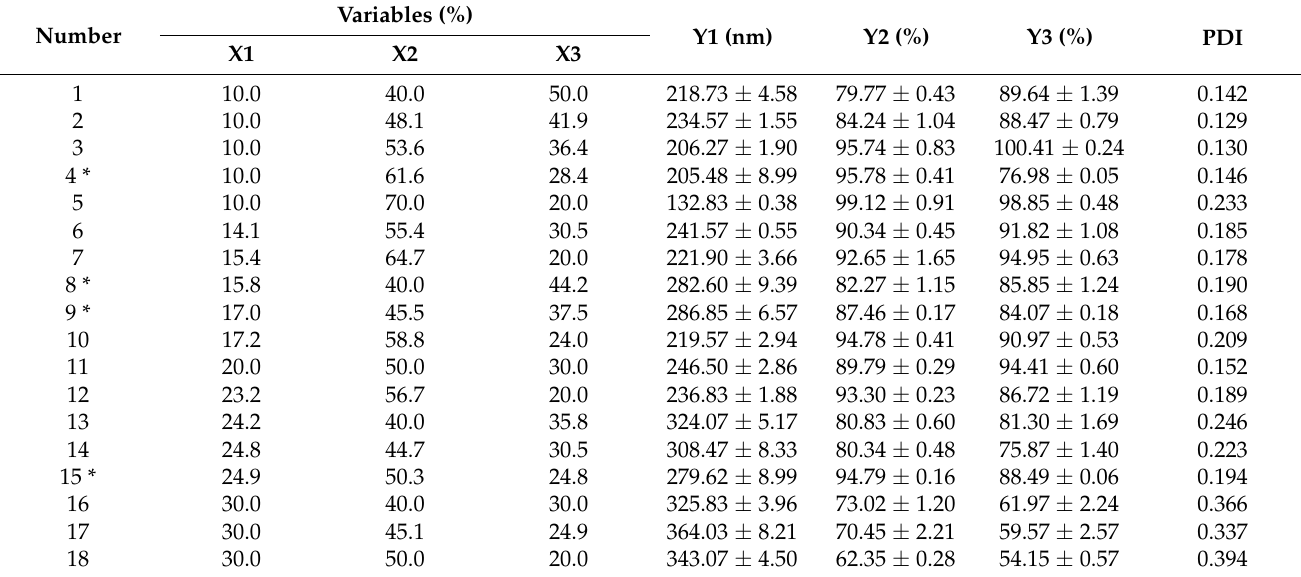
Formulations from randomized runs in D-optimal mixture design (Capryol ®